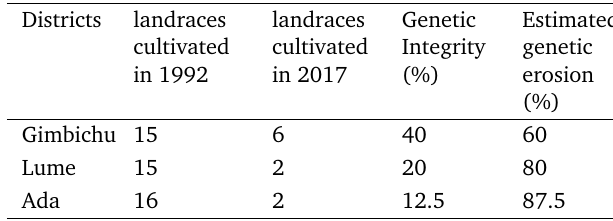
Table 1. Genetic erosion on tetraploid wheat since 1992 in three districts of the central highlands of Ethiopia